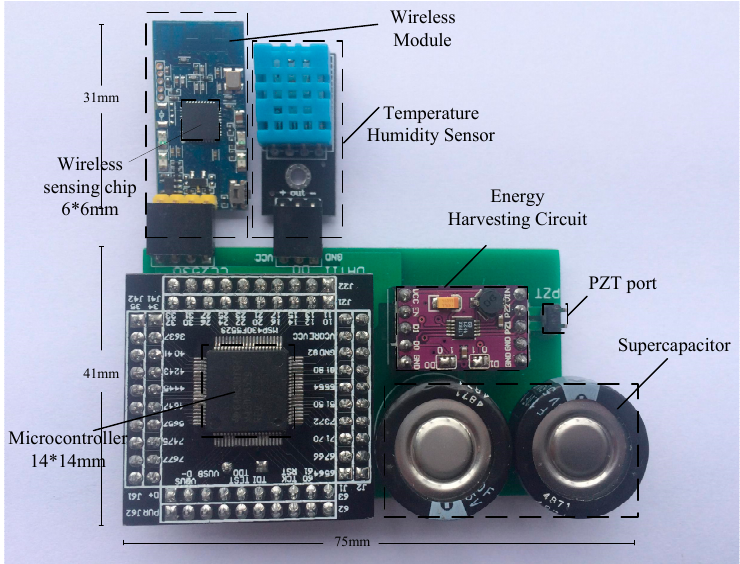
Figure 21. The Minimum system.